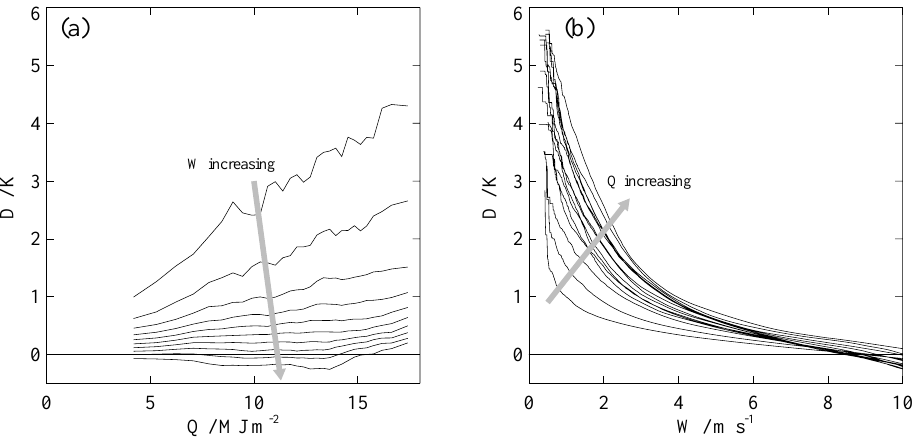
Fig. 2. Result of direct frequency matching, for 14:00LT. (a) Warming D as a function of integrated heat flux Q for various maximum 6-hourly wind speeds W ; W ranges from 1 to 10ms − 1 . (b) Warming D as a function of maximum 6-hourly wind speed W for various values of the integrated heat flux Q ; Q ranges from 4.2 to 17MJm − 2 (in unequal steps).